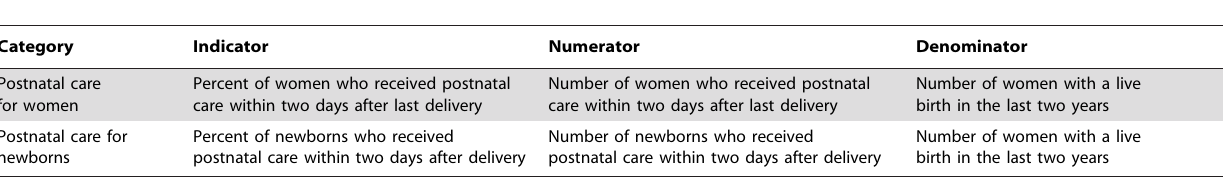
Table 2. Global indicators for postnatal care coverage,